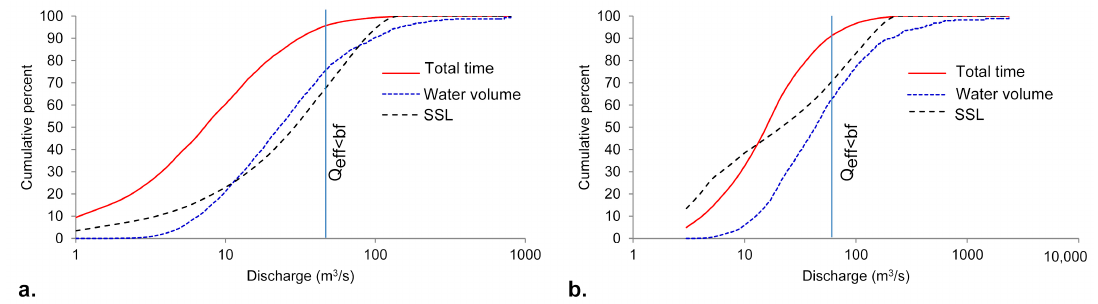
Figure 9. Cumulative suspended sediment-water-time curves during 1994–2014. ( a ) Târgu Ocna; ( b ) Vrânceni. The percentages of discharge that were needed to transport 10%, 50%, and 90% of the suspended sediments were calculated and are shown in Table 6 and Figure 10. From 1994 to 2014, 10% of